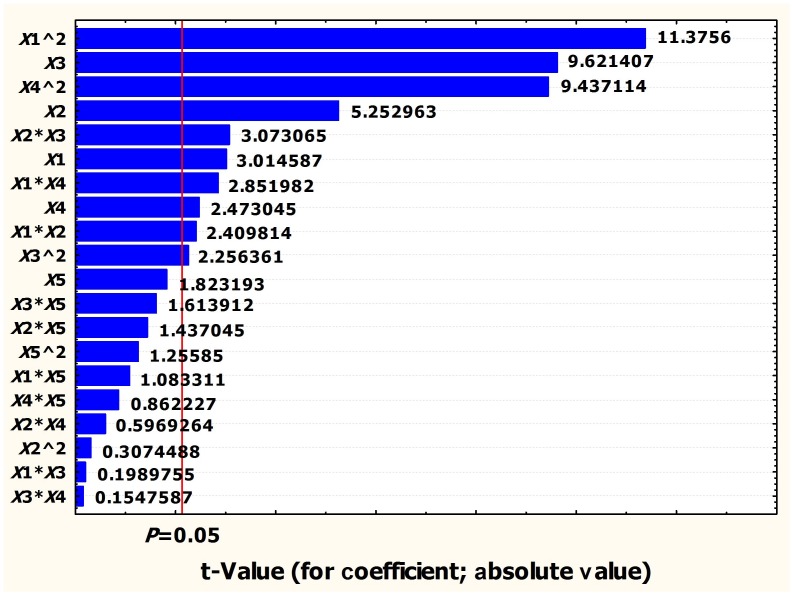
Pareto chart of t-values for coefficients.